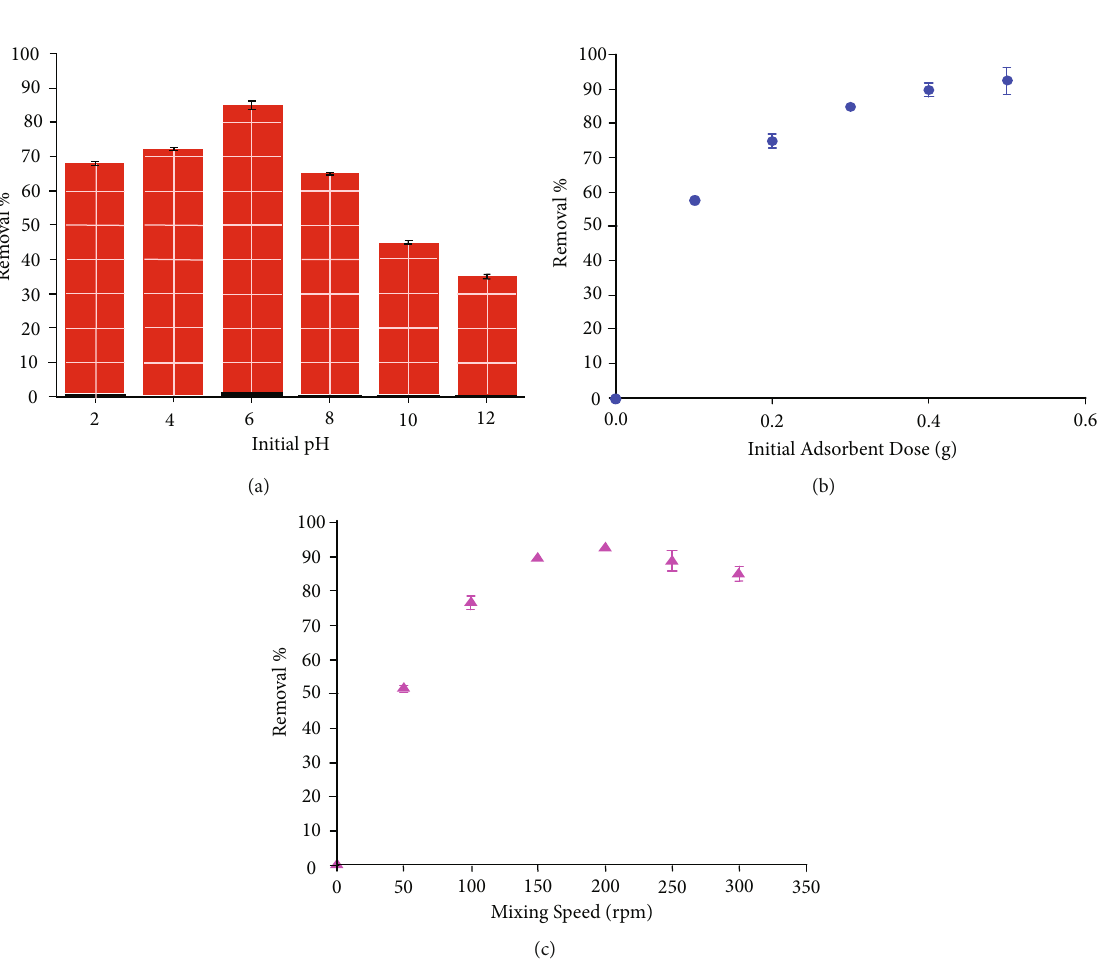
Figure 3: The removal e ffi ciency of phenol at (a) various pH levels at an applied adsorbent dose = 0 : 5g , initial phenol concentration = 100mg/L , contact time = 2 h , and stirring speed = 200 rpm ; (b) various adsorbent doses at an initial phenol concentration = 400 mg/L , pH = 6 , contact time = 2h , and stirring speed = 200rpm ; and (c) various stirring speeds at an initial phenol concentration = 400mg/L , pH = 6 , contact time = 2h , and applied adsorbent dose = 0 : 5g